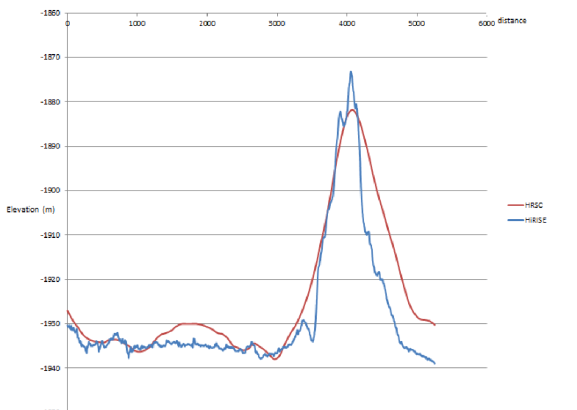
Figure 9. Profile A showing elevation of HiRISE (blue) and HRSC (red)